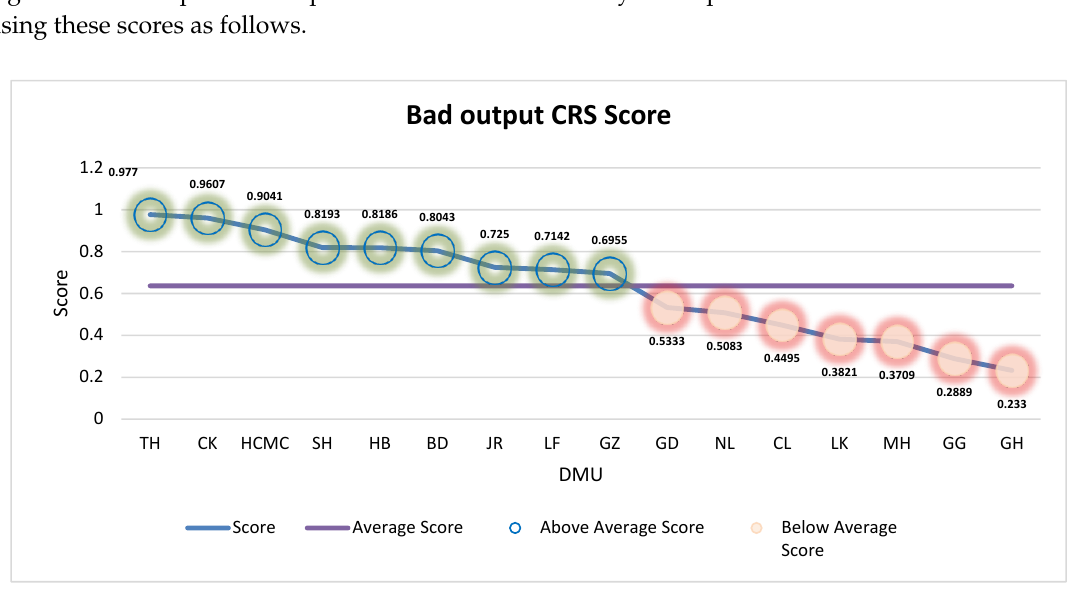
Figure 3. TEC Slacks.